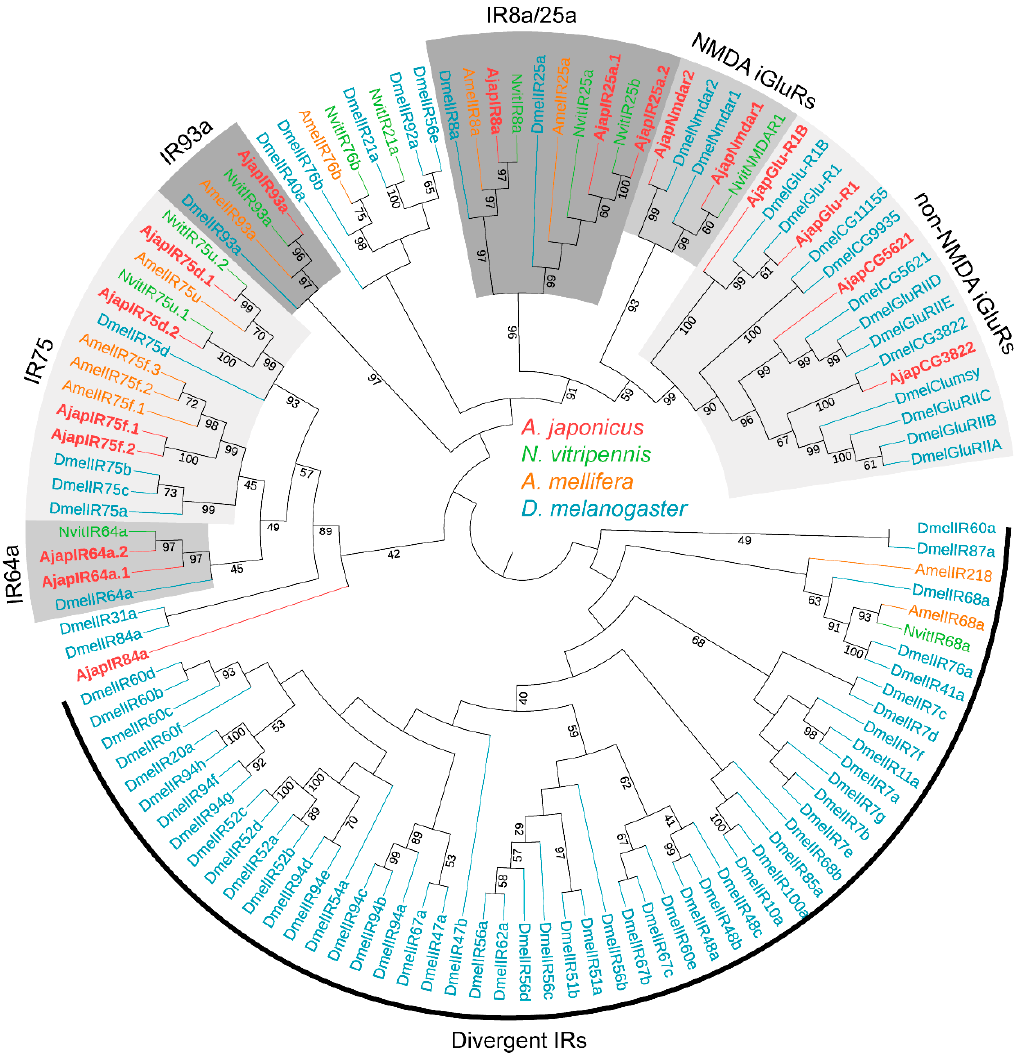
Figure 2. Phylogenetic tree of ionotropic receptors (IRs). Ajap: Anastatus japonicus (red); Nvit: Nasonia vitripennis (light green); Amel: Apis mellifera (orange); Dmel: Drosophila melanogaster (blue). Numbers at nodes represent support values higher than 40, where 100 represents maximal support.